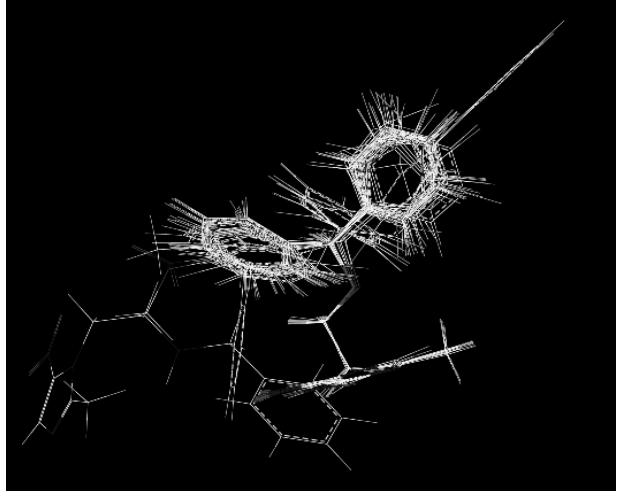
Figure 2. Alignment of the training set